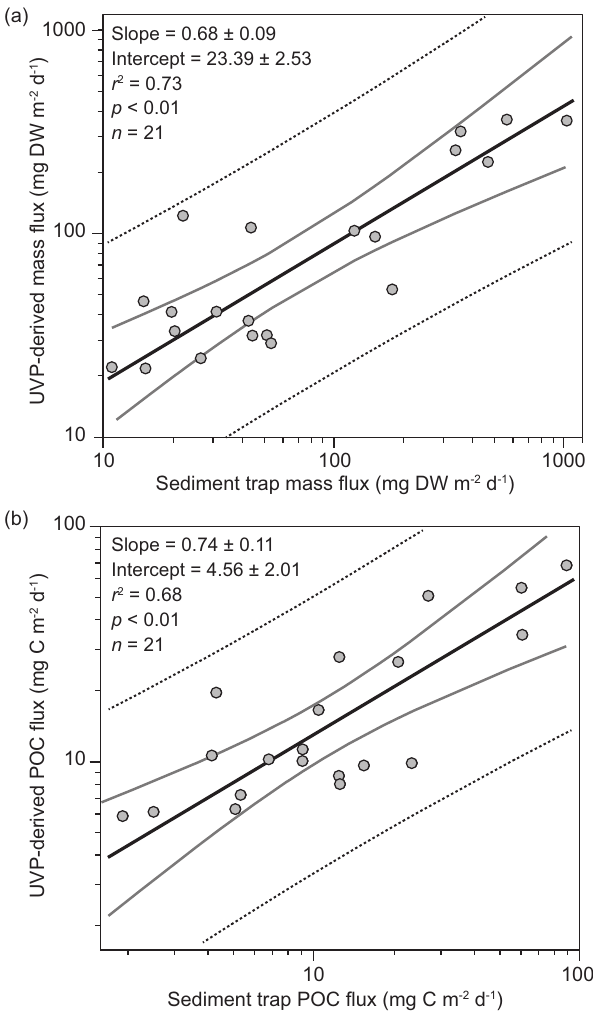
Fig. 8. Regressions of vertical mass fluxes (a) and particulate or- ganic carbon (POC) fluxes as estimated with the UVP5 dataset and the empirical equations obtained with the minimization procedure (Table 2) against the mass fluxes and POC fluxes recorded by the in situ sediment traps (Table 1). See Appendix A for a rationale and sensitivity analysis conducted on the empirical equations obtained with the optimization